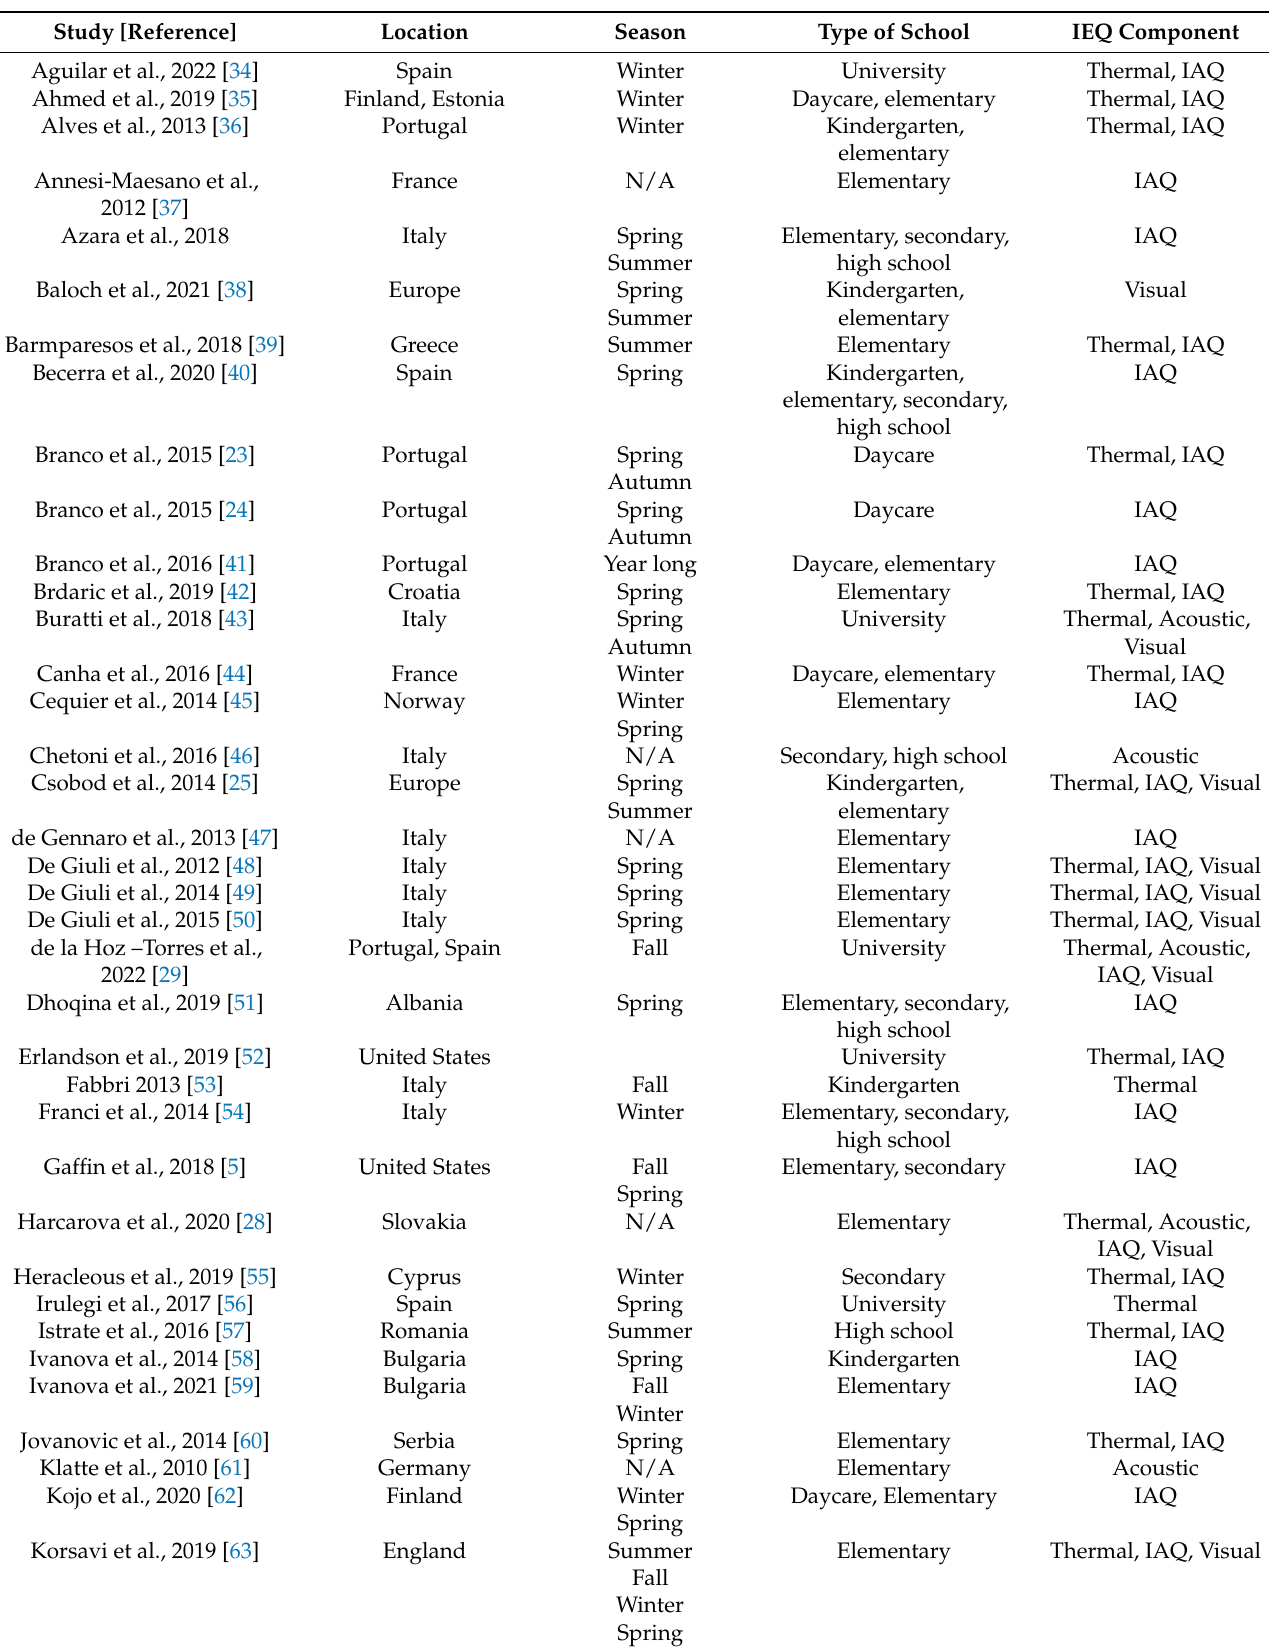
Table 1. Summary of the investigated studies ( n = 88